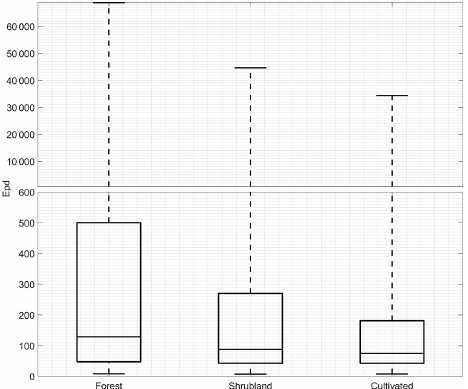
Figure 6. As in Fig. 4 but for the distribution of daily energy (GJ) released per pixel stratified by type of vegetation cover/land